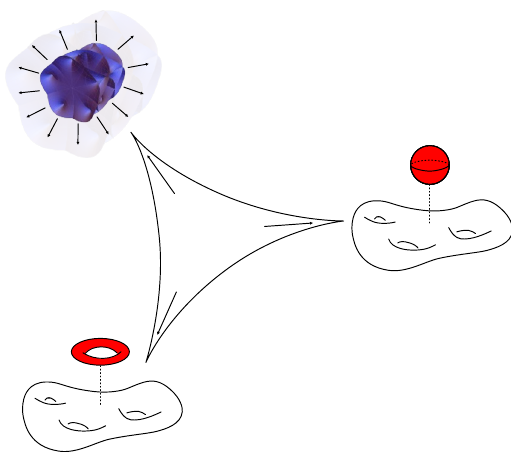
Figure 4 . Shown are the possible in(cid:12)nite distance limits in the K(cid:127)ahler moduli space of F-theory compacti(cid:12)ed to four dimensions with N = 1 supersymmetry. These are either decompacti(cid:12)cation limits (upper left corner) or limits in which a unique heterotic (upper right corner) or Type II string (lower left corner) becomes tensionless (at the fastest rate) with respect to the four-dimensional Planck